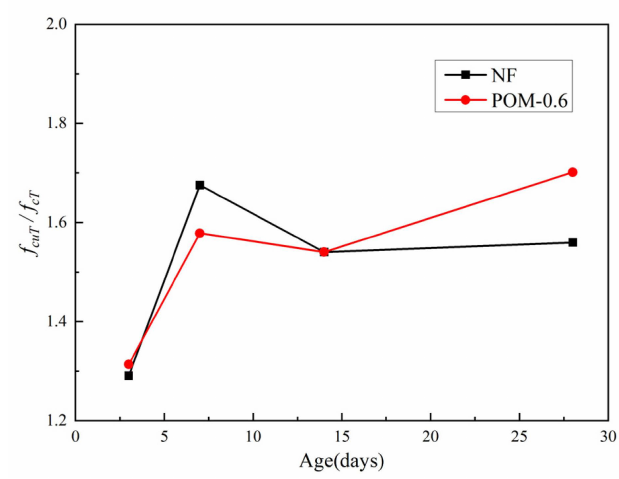
Figure 10. Relations between f cT / f c28 and concrete age.